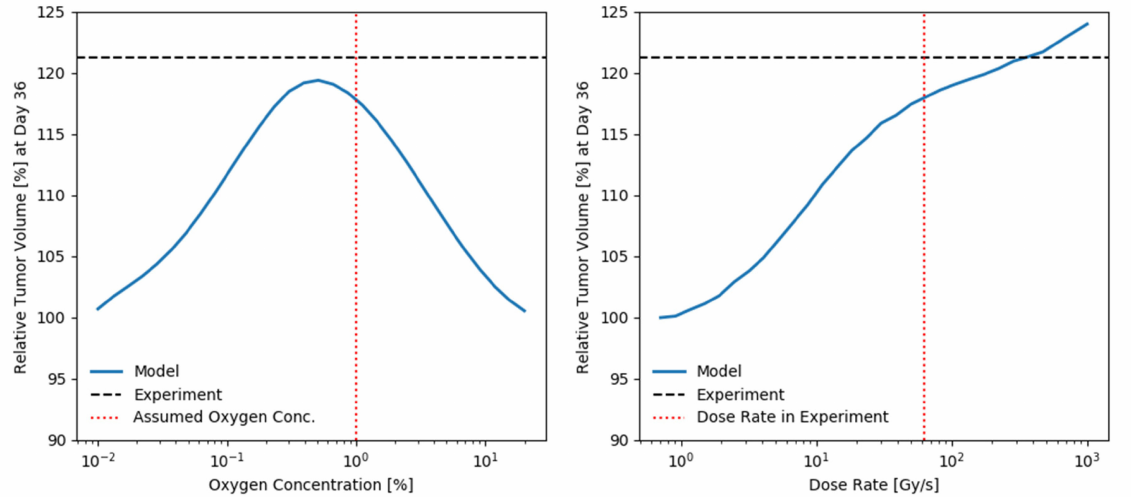
Figure 2. Predicted relative tumor volume 36 days after irradiation with 18 Gy between SDR and uHDR applying model parameters obtained for the data by Diffenderfer et al. [21] in dependency of the assumed oxygen level and dose-rate of the uHDR beam. For reference, the value measured in the original study is shown as a horizontal black dashed line. The oxygen level assumed for the predictions in Figure 1 and the dose rate applied in the experiment are marked by a vertical red dotted lines in the respective panels. ( left ): For the applied parameters, a maximum sparing is seen at an oxygen concentration of about 0.5% and the tumor volume of the uHDR group is predicted to be increased by 10% or more for any oxygen concentration between ~0.07 and 4%. ( right ): The relative tumor volume is seen to continuously increase with the dose-rate of the uHDR